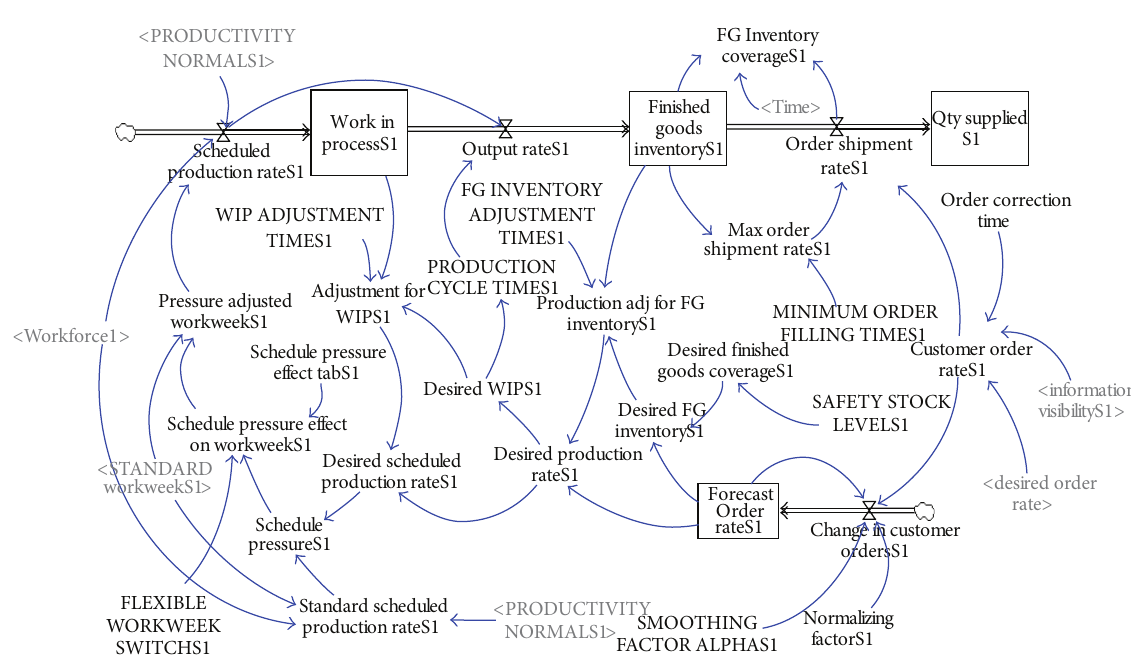
Figure 2: Supplier/manufacturer’s setup—production and inventory